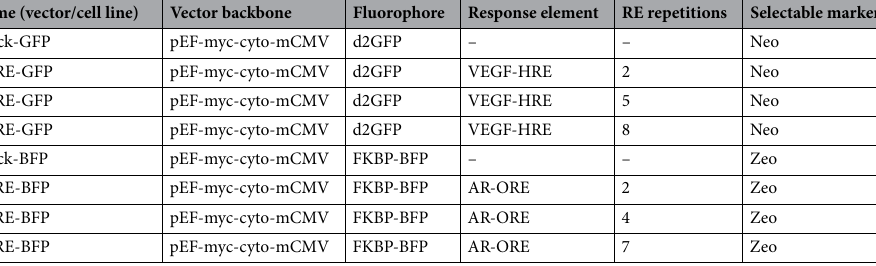
Table 1. Generated vector constructs for the analysis of HRE and ORE